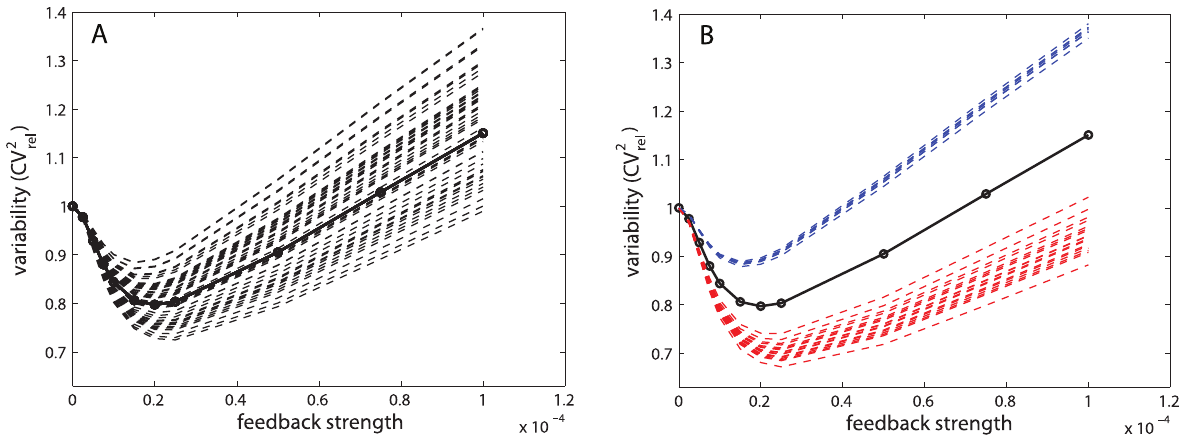
Figure 11. Total variability resulting from non-diagonal covariance matrices. (A) Simulations of total variability resulting from 50 representative random correlation matrices selected from 1000 runs for visual clarity (dashed line) and a diagonal correlation matrix (solid line). (B) From a total of 1000 random correlation matrices, those resulting from correlation matrix (eqn. 6) are shown in red, and those correlated oppositely in blue. Simulation resulting from a diagonal correlation matrix is represented by a solid black line.